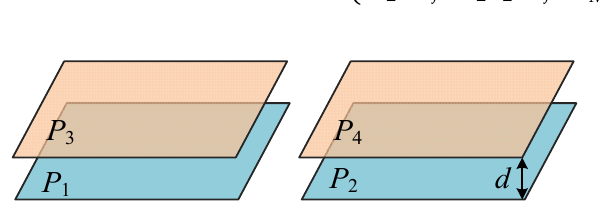
Figure 2. Classic four-plate capacitive coupler structure.